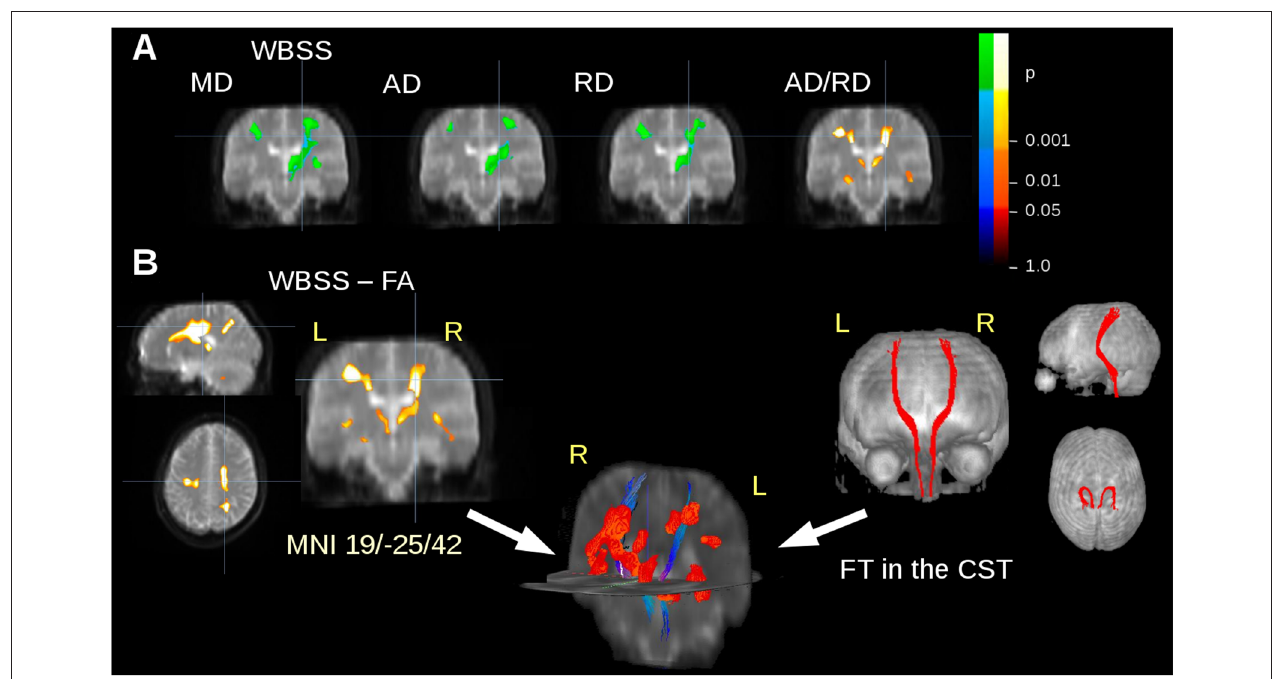
FIGURE 2 | DTI metrics alterations at the group level. (A) Whole brain-based spatial statistics (WBSS) of the comparison amyotrophic lateral sclerosis (ALS) patients vs. controls: results clusters of mean diffusivity (MD), axial diffusivity (AD), radial diffusivity (RD), and the ratio AD/RD for coronal slice at y = − 25. (B) Results clusters for Fractional anisotropy (FA) maps (as an example representative for all calculated DTI metrics) and projectional views of fiber tracking (FT) of the corticospinal tract (CST). Overlap of fiber tracts along the CST and FA differences at the group level in 3-D view. Increase is displayed in cold colors, decrease is displayed in hot colors.